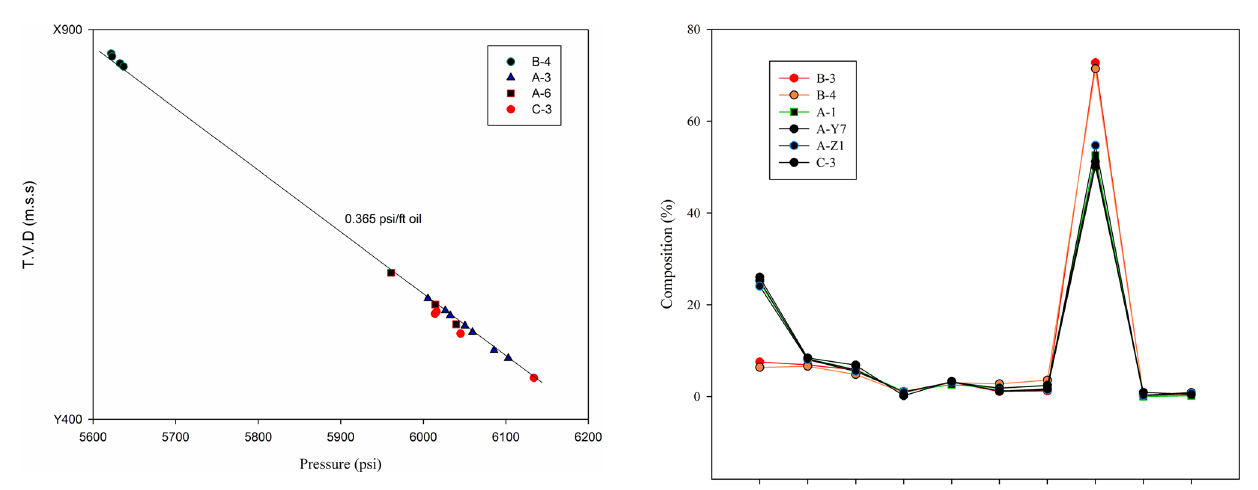
Fig. 9 Pressure–depth plot in the three fields before production from all fields. This plot illustrates the pressure communication between these fields at initial condition Fig. 10